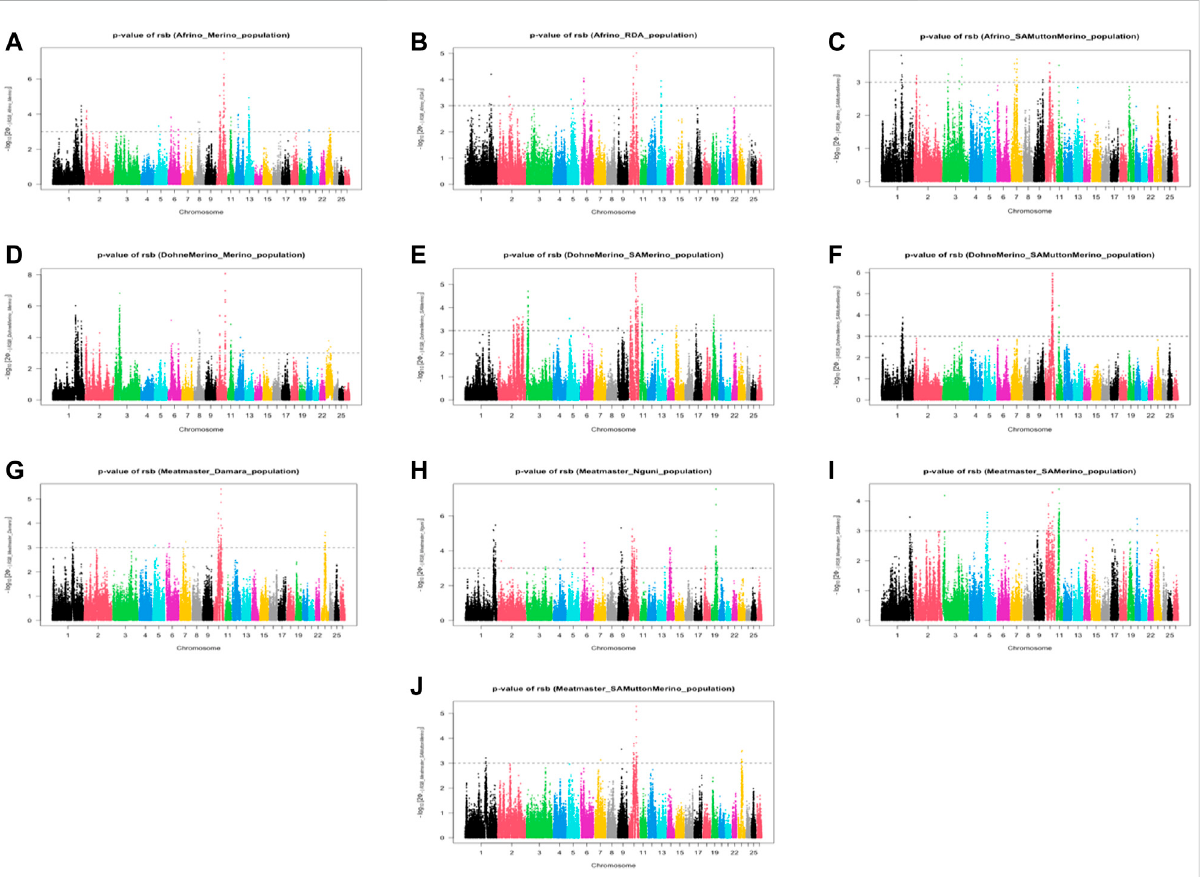
FIGURE 4 Genome-wide XP-EHH and Rsb scores of Merino-derived breeds and against their presumedancestors. Afrino and Merino (A) , Afrino and RDA (B) , Afrino and SAMuttonMerino (C) , Dohne Merino and Merino (D) , Dohne Merino and SAMerino (E) , Dohne Merino and SAMuttonMerino (F) , Meatmaster and Damara (G) , Meatmaster and Nguni (H) , Meatmaster and SAMerino (I) and Meatmaster and SAMuttonMerino (J)